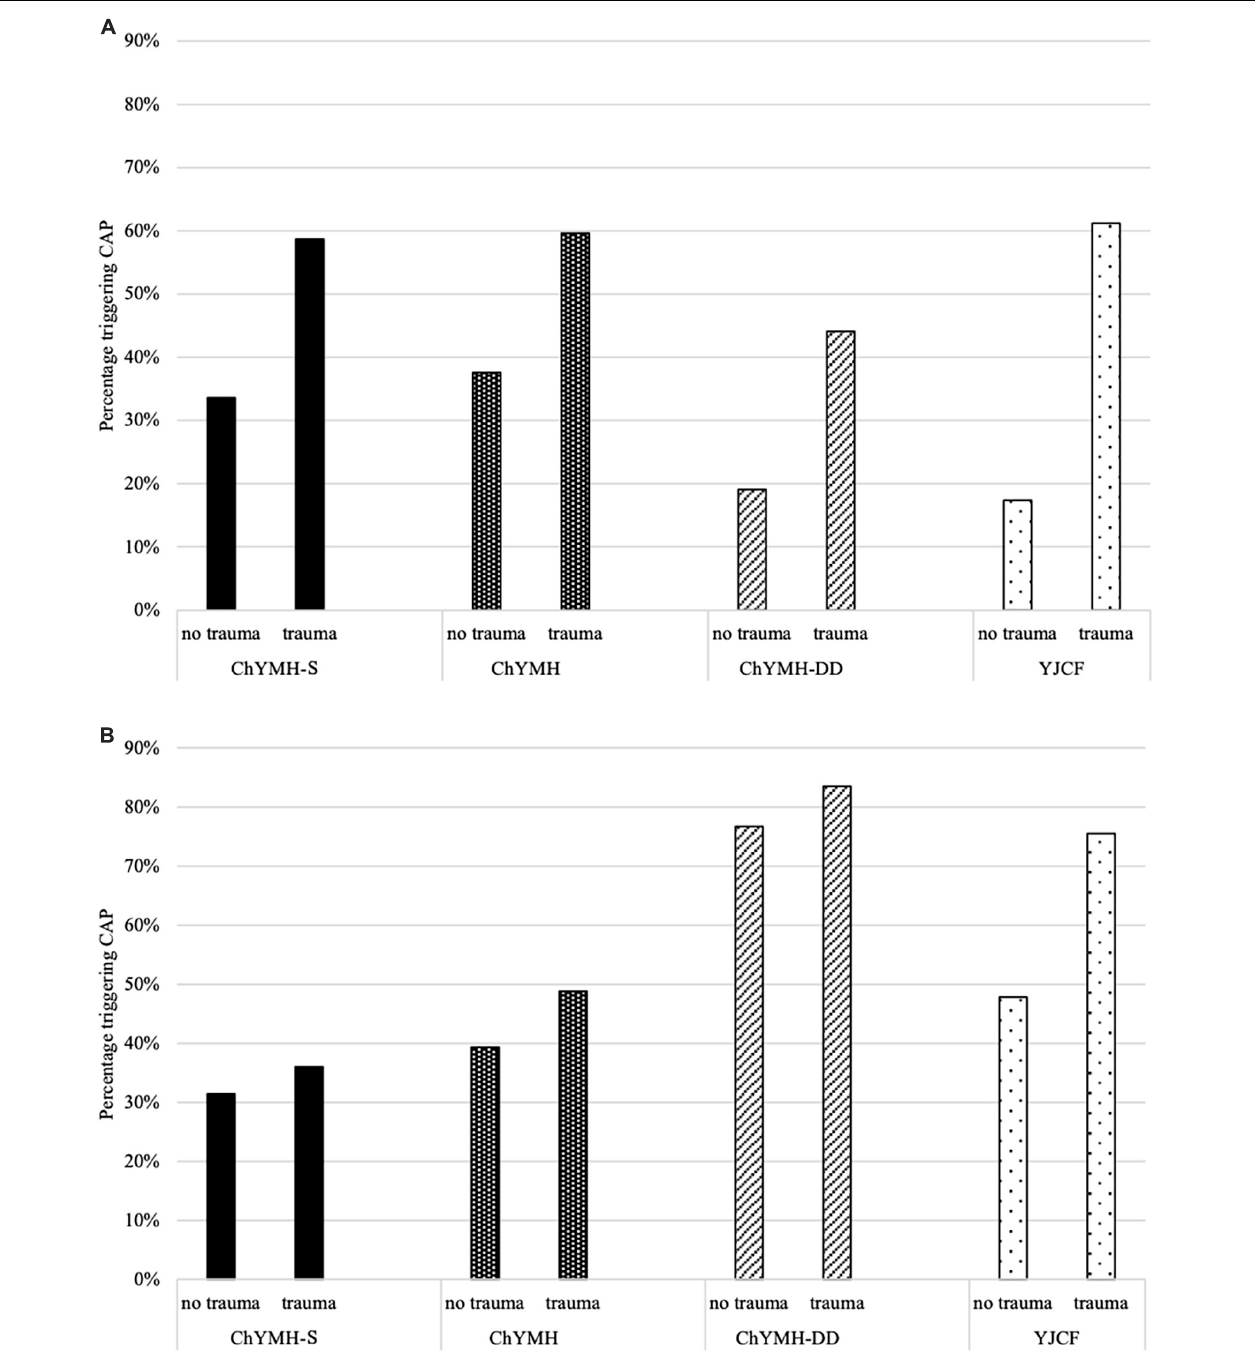
FIGURE 2 | (A) Triggering rates for the Suicidality and Purposeful Self-Harm CAP, by trauma and instrument. (B) Triggering rates for the Harm to Others CAP, by trauma and instrument.